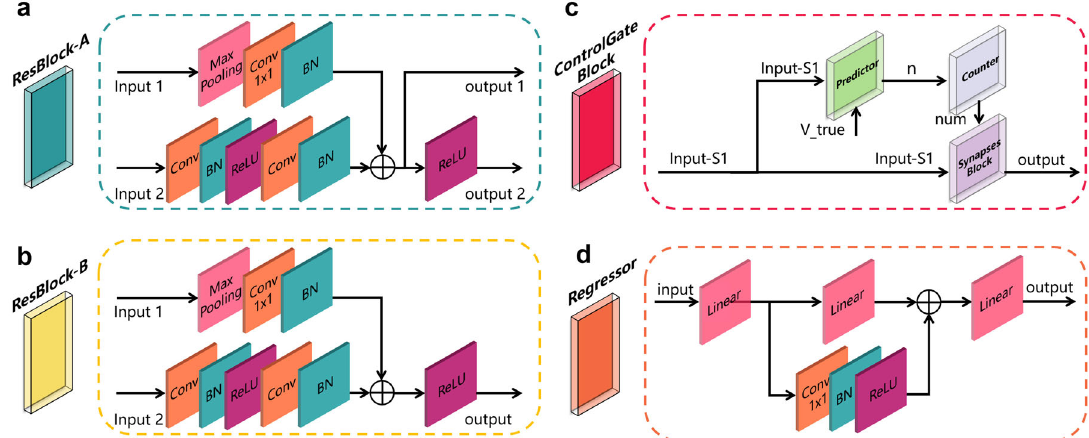
Fig. 6 The four units of the proposed framework. a ResBlock-A architecture, containing two convolution layers with 3 × 3 kernels, one convolution layer with a 1 × 1 kernel, three batch normalization layers, two ReLu layers, and one max-pooling layer with a 3 × 3 kernel. b ResBlock-B architecture; the basic unit is the same as the ResBlock-A, except for output 1. c The Control Gate Block has a synaptic-based frontend architecture that controls the direction of